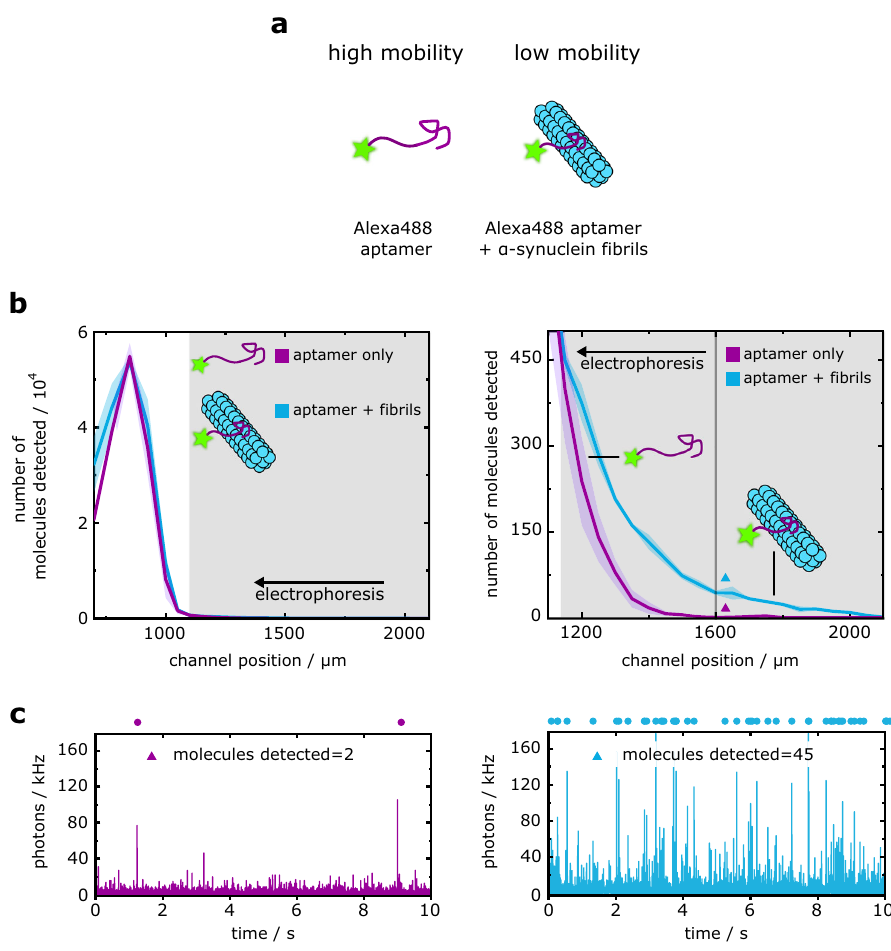
Fig. 4 | Sensing of α -synuclein fi brils at high aptamer probe concentrations. a Binding of an α -synuclein aptamer to fi brils reduces the electrophoretic mobility of the aptamer probe, allowing for the discrimination between fi bril-bound and unboundaptamerspecies. b Electropherogram(leftpanel)asobtainedbyscanning oftheconfocalvolumeacrossthecross-sectionofthechannelinastepwisemanner forthe α -synuclein fi brils – aptamer sample (blue line; average of N =3 repeats) and forthefreeaptamerprobe(purpleline;averageof N =3repeats).Theshadedbands correspond to the standard deviation. The right panel shows a zoom-in region of the electropherogram. The shaded region in grey where the concentration of the complex exceeded that of the free probe (1150 µ m < x <2000 µ m) was used to estimate the concentration of the fi brils (see main text). Note, the photon arrival